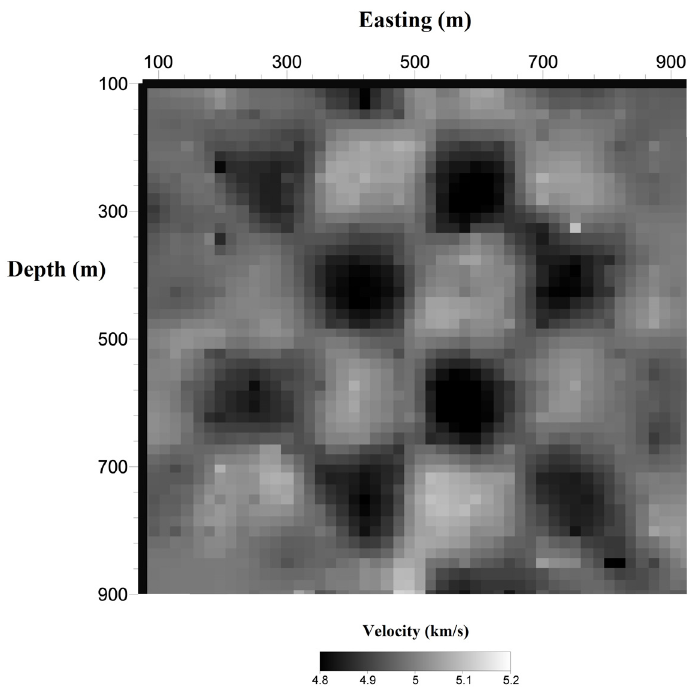
Figure 9. Tomogram showing the checkerboard velocity model with an ideal event and receiver arrangement.